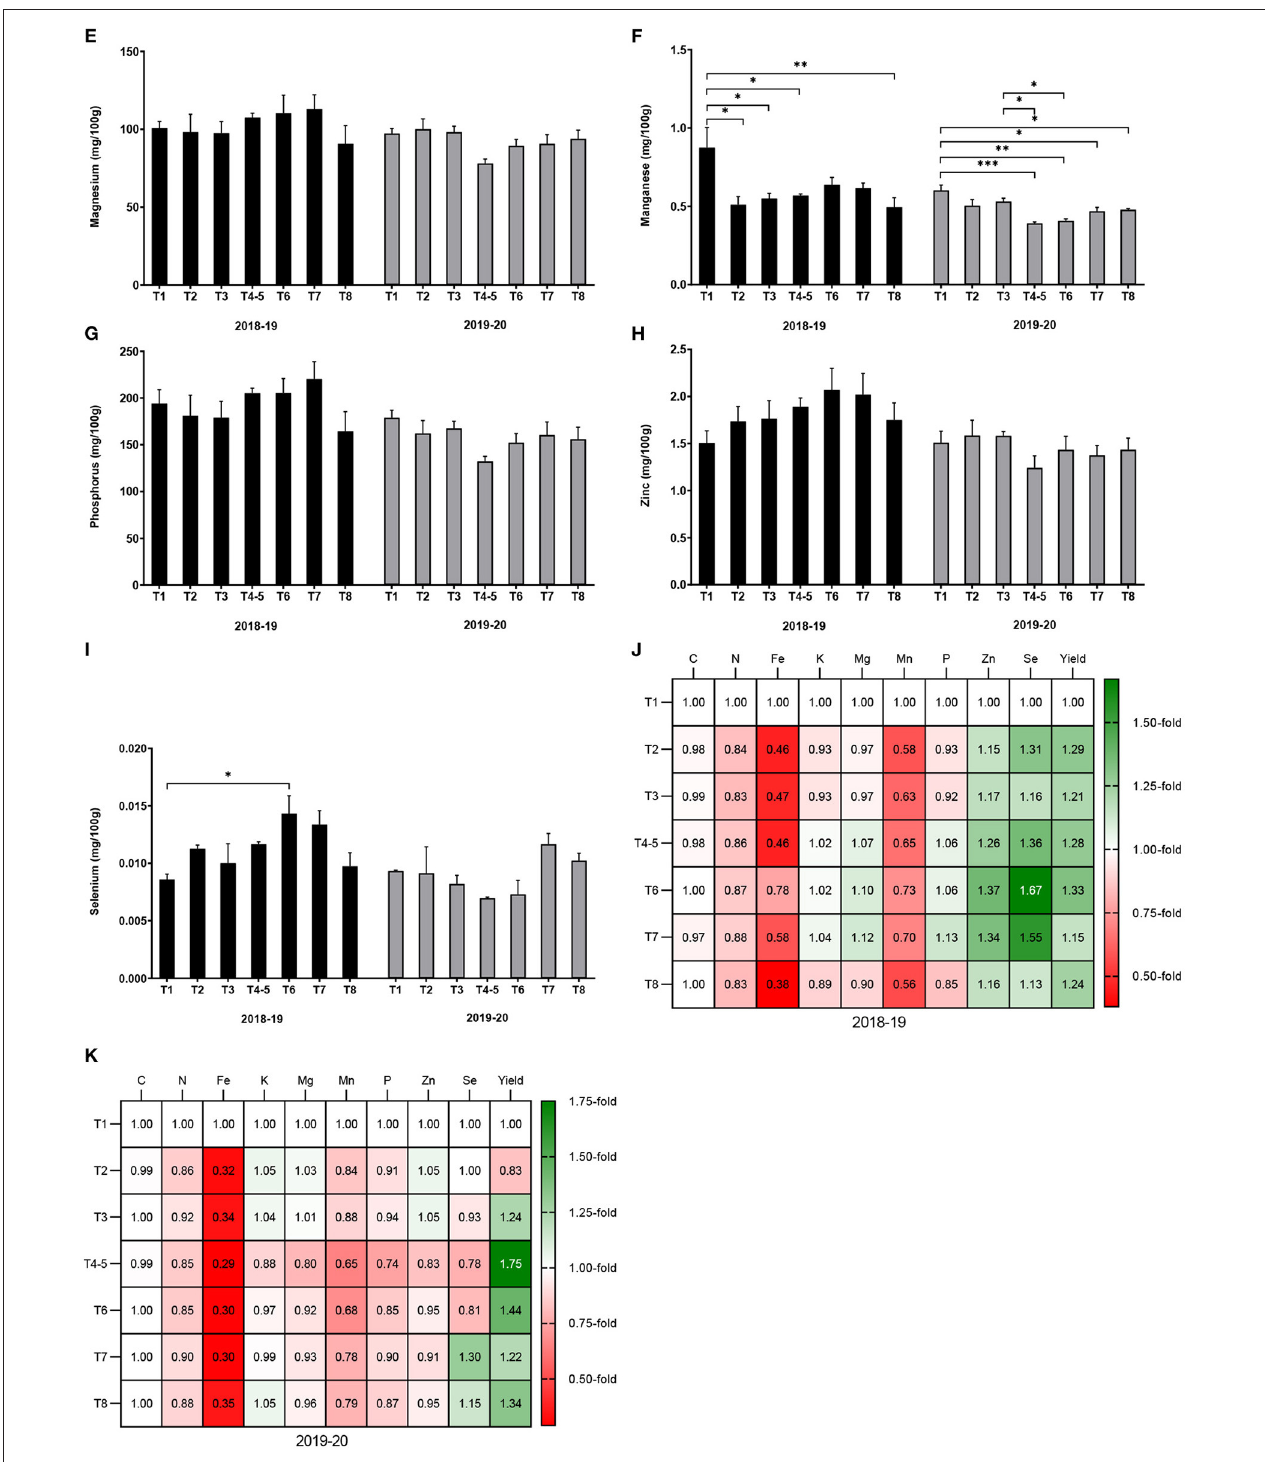
FIGURE 5 | Effect of conservation agriculture on the nutrient content of maize variety DKC 9089 during two seasons of field trials. Error bars represent SEM. *, **, and *** mean, significant at 0.05, 0.01, and 0.001, respectively, Tukey’s HSD test. Values in (J,K) are the number of fold-change compared to treatment T1 (conventional practise). Treatments: T1 = conventional agriculture; sole maize. T2 = conservation agriculture (CA); basin sowing; sole maize. T3 = CA; dibble stick sowing; sole maize. T4–5 = CA; dibble stick sowing; maize-cowpea rotation. T6 = CA; dibble stick sowing; maize-pigeon pea intercrop. T7 = CA; dibble stick sowing; maize-cowpea intercrop. T8 = CA; dibble stick sowing; maize-velvet bean intercrop.